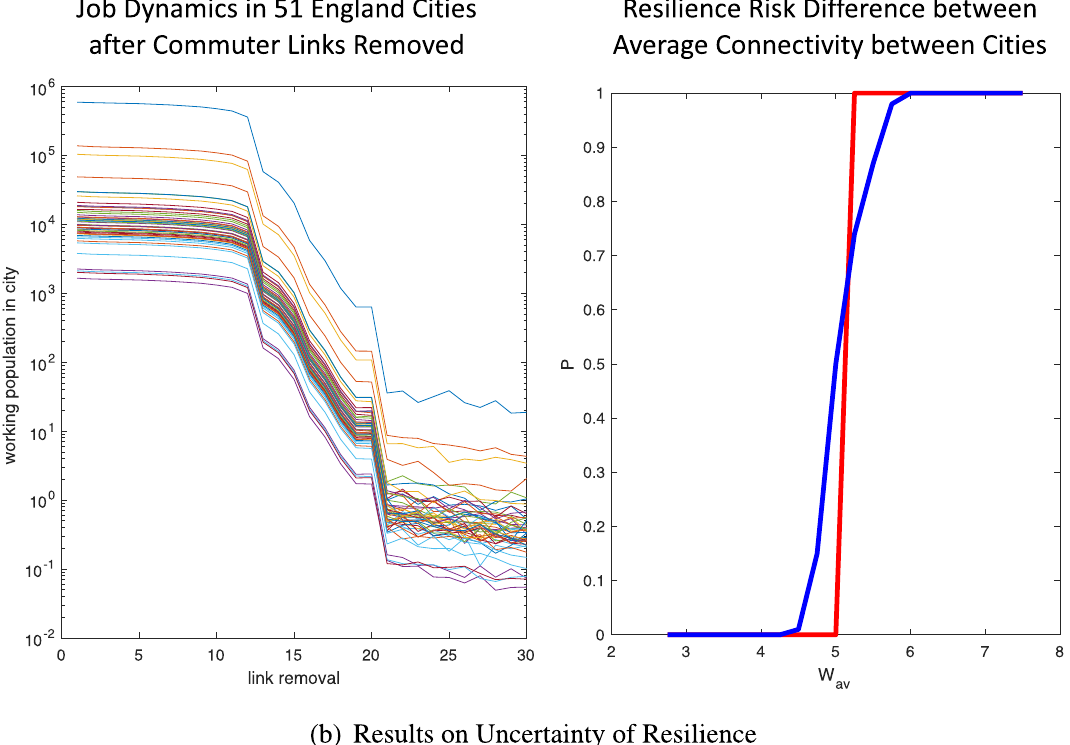
Figure 9. UK commuter network with urban job dynamics coupled by a competitive commuter mobility model. ( a ) Raw data consists of census data of home to work travel across 34,000 Lower Layer Super Output Areas (LSOA). This is then clustered to nearest major cities and the number of services for commuting inform the weight of the matrix. ( b ) simulated labor mobility dynamics with transport link removal causes simulated mobility dynamics to